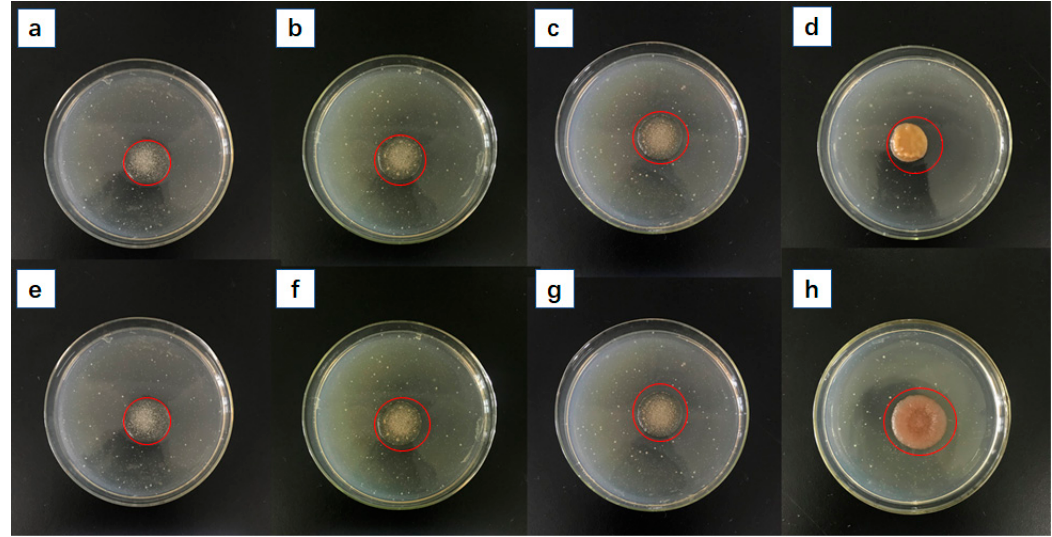
Figure 7. Inhibition zone photographs of Z0, Z1, Z2 and Z3 against bacteria S. aureus ( a – d ) and E. coli ( e – h ).